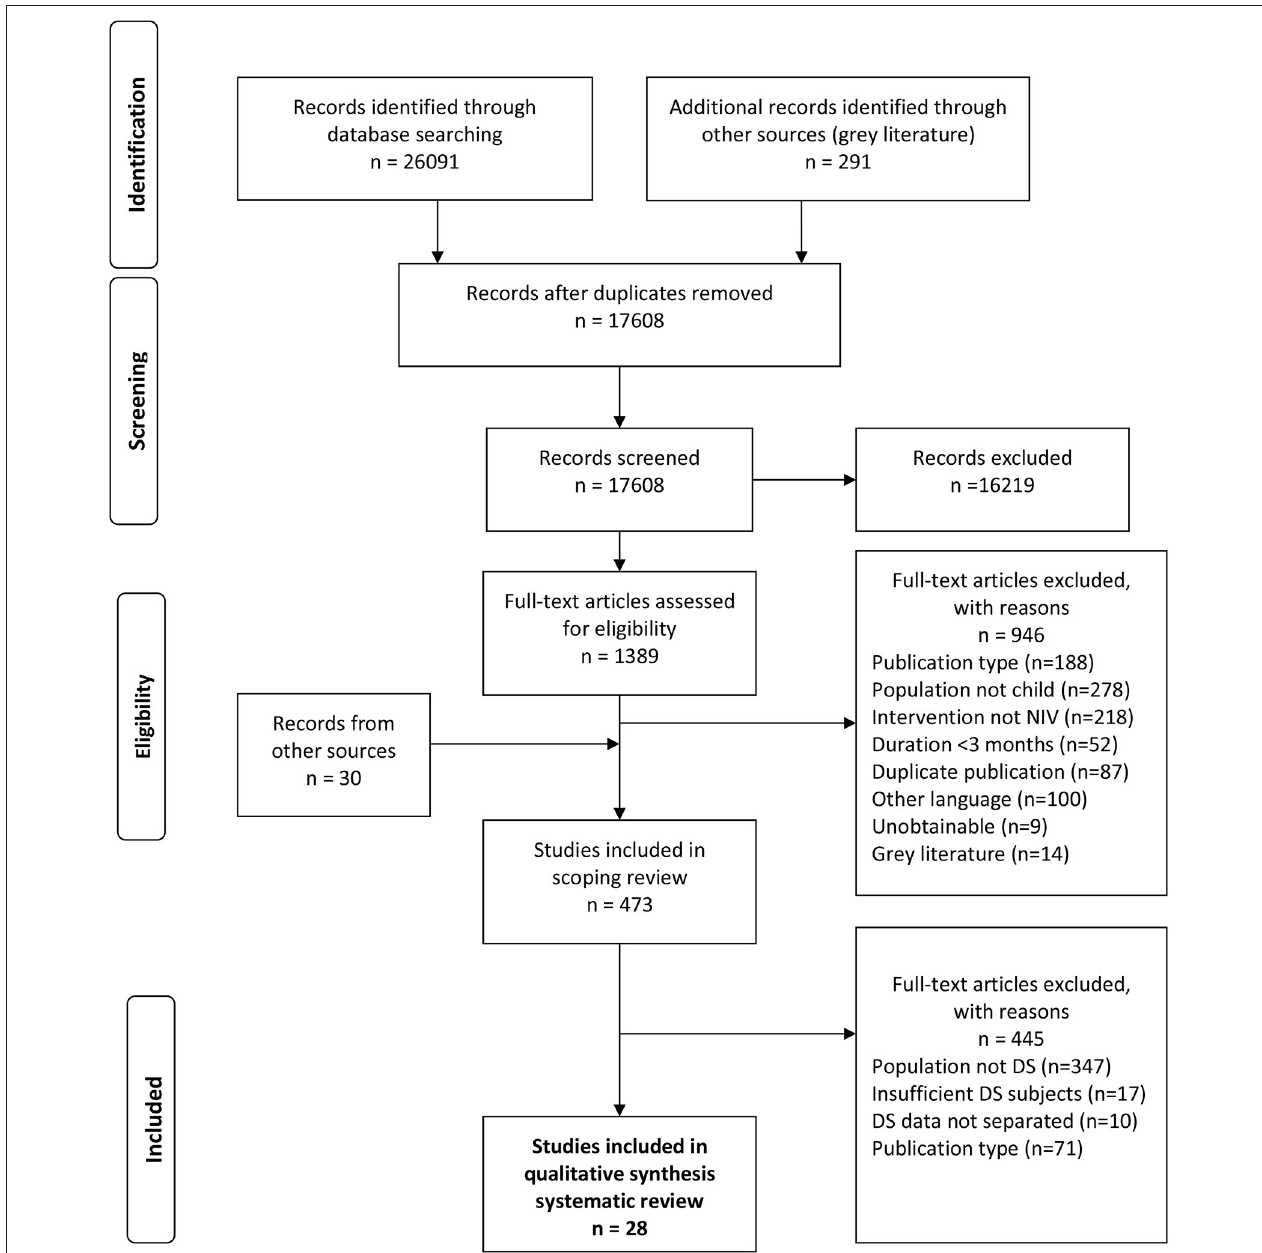
FIGURE 1 | Flow diagram outlining the study selection process for the systematic review, following the Preferred Reporting Items for Systematic Reviews and Meta-Analyses (PRISMA) guidelines (11). The protocol and scoping review results provide the details of the search strategy (10).